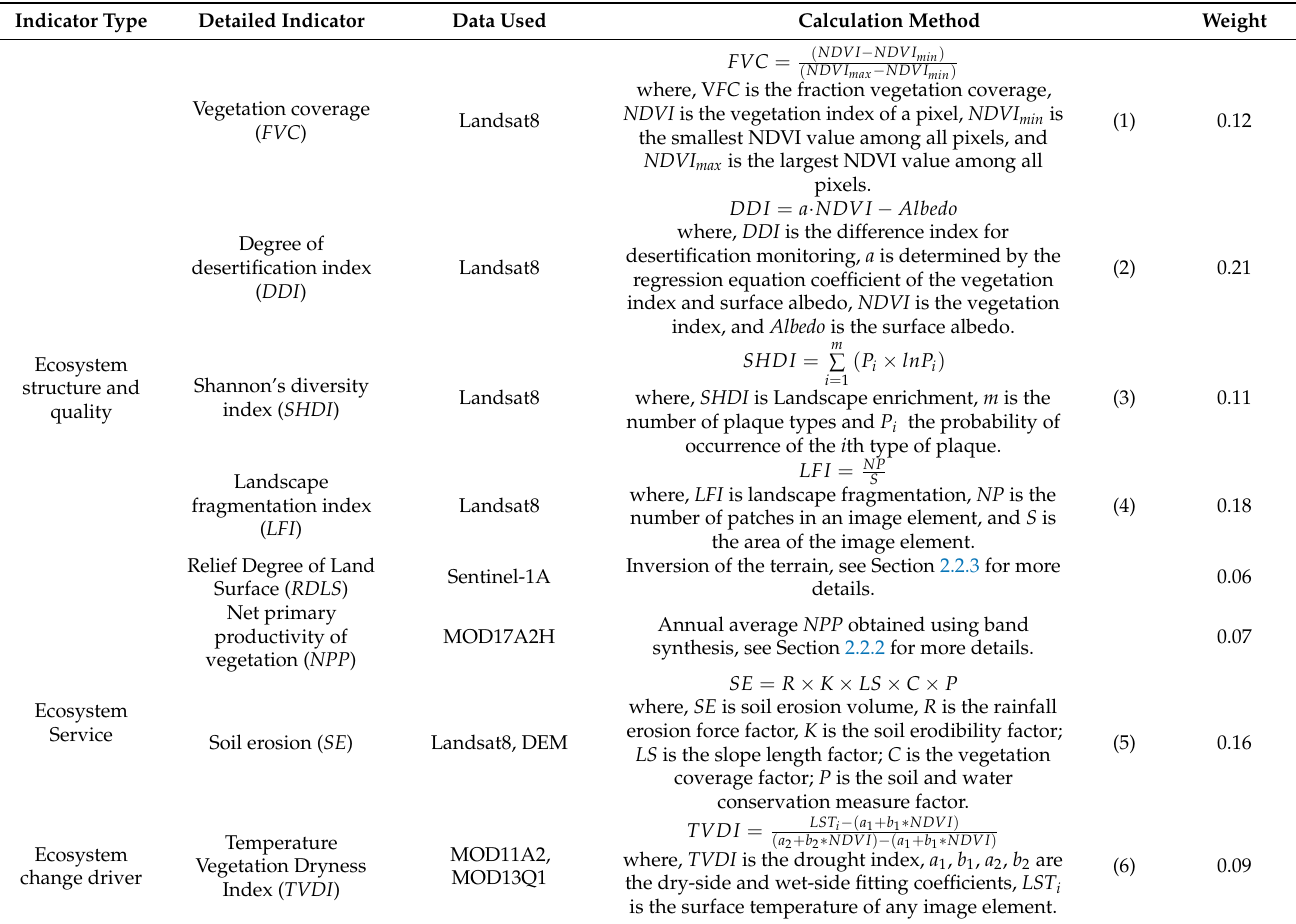
Table 2. Evaluation index system of ecological restoration effect in the Wuliangsuhai